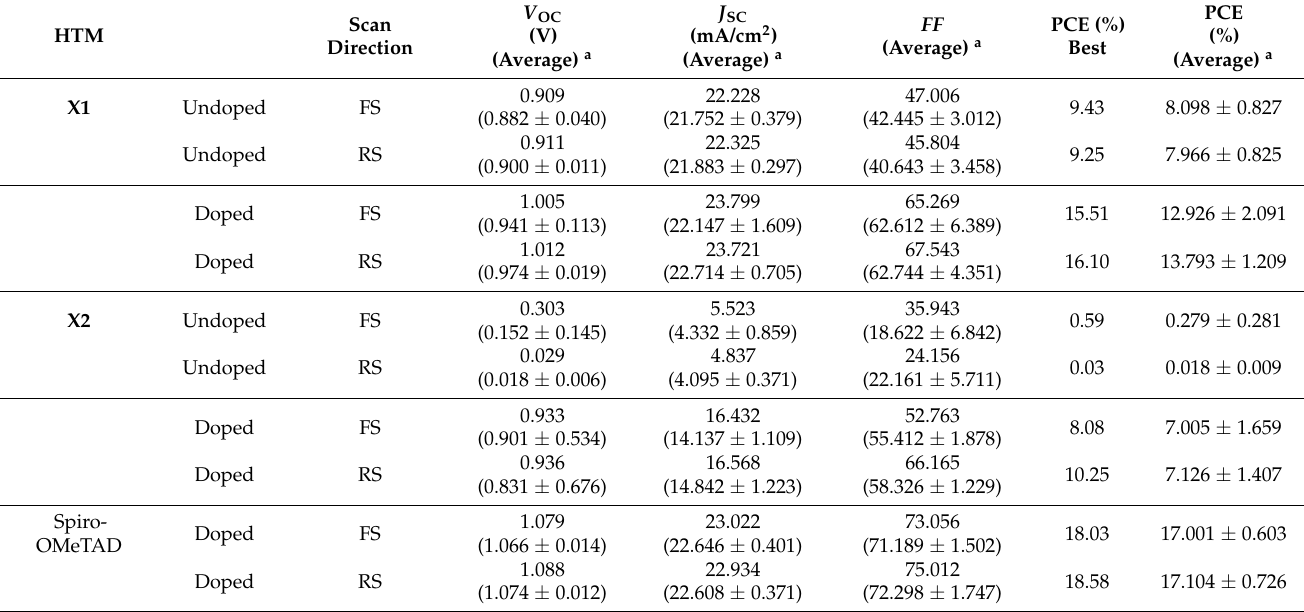
Figure 9. ( a ) J − V curves of the most efficient PSCs employing X1 , X2 , and spiro-OMeTAD under AM 1.5 illumination; ( b ) IPCE spectra for the devices with doped and undoped X1 , and spiro-OMeTAD; ( c ) Stability test on PSCs based on the doped X1 , X2 and spiro-OMeTAD HTMs. Table 2. Photovoltaic performances of PSCs with X1 and X2 HTMs compared with the reference HTM with spiro-OMeTAD.